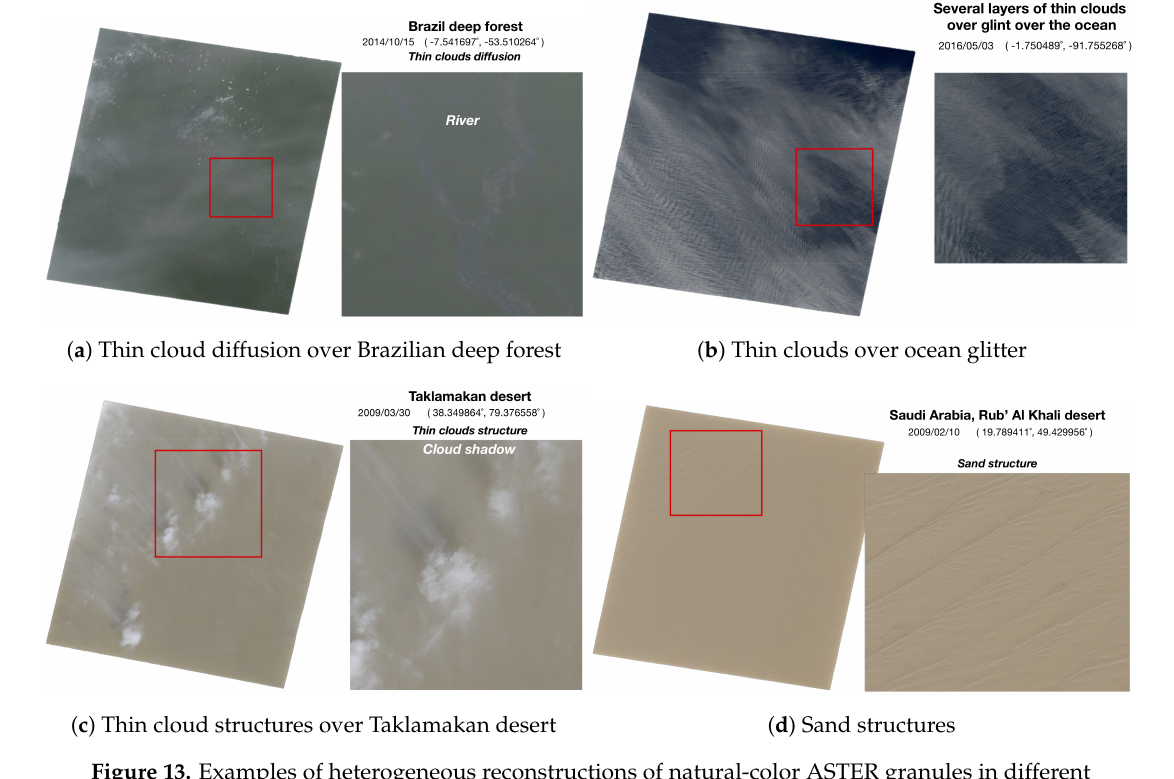
Figure 13. Examples of heterogeneous reconstructions of natural-color ASTER granules in different areas. The left figure is the ASTER granule and the right inset a zoom into the red